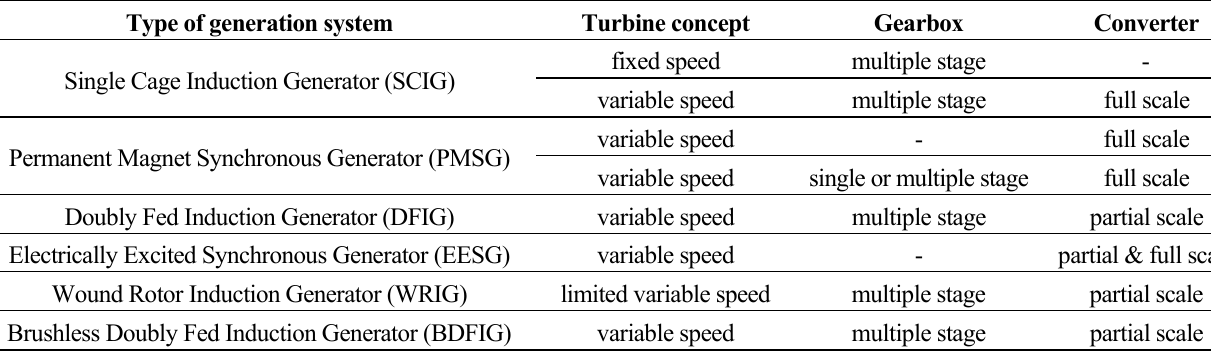
Table 5. Existing wind turbine systems in